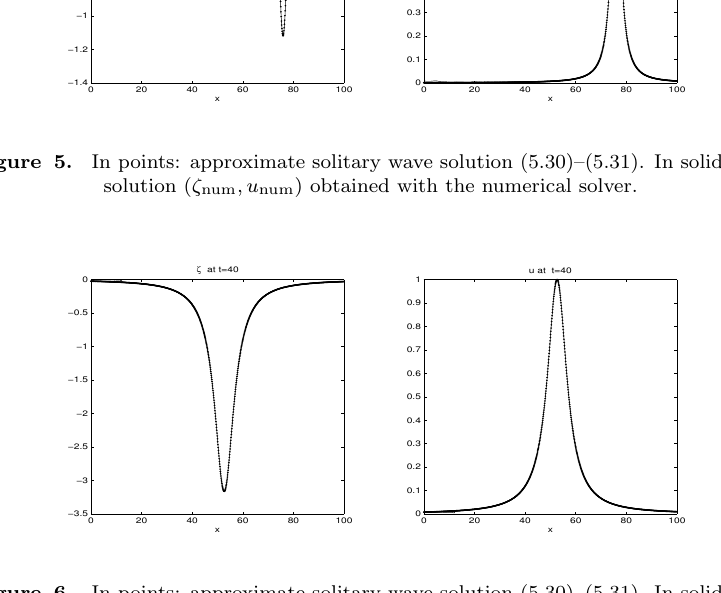
Figure 6. In points: approximate solitary wave solution (5.30)–(5.31). In solid line: solution ( ζ num ,u num ) obtained with the numerical